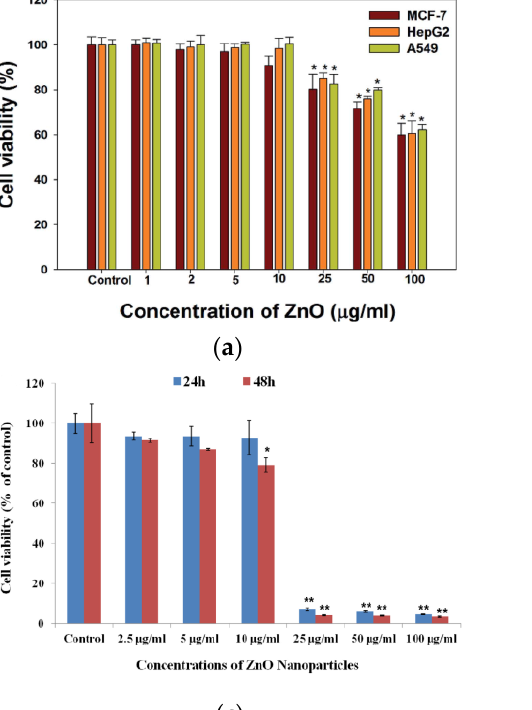
20 of 50 Figure 24. Changes in mitochondrial membrane potential of Leydic cells (LCs; top panel) and Sertoli cells (SCs; bottom panel) treated with 15 µg/mL ZnO NPs for 0, 3, 6, and 12 h using cationic JC-1 dye. Reproduced from [143] under the Creative Commons Attribution. 4.1.2. Cancerous Cells Nano-ZnO materials have been reported to attack multiple cancer cell lines based on cytotoxic assay results [50,126,147–162]. Very recently, Hussain et al. synthesized spherical ZnO NPs (90 nm) from Pandanus odorifer leaf extract and zinc acetate dihydrate. The anticancer activity of green ZnO NPs of different concentrations (1, 2, 5, 10, 25, 50, and 100 µg/mL) against MCF-7 (breast cancer), HepG2 (liver cancer), and A549 (human lung adenocarcinoma) cells using MTT and neutral red uptake (NRU) assays was studied [157]. The anticancer activity of green ZnO NPs to human carcinoma cells was found to be dose-dependent. Green ZnO NPs inhibited the proliferation of cancer